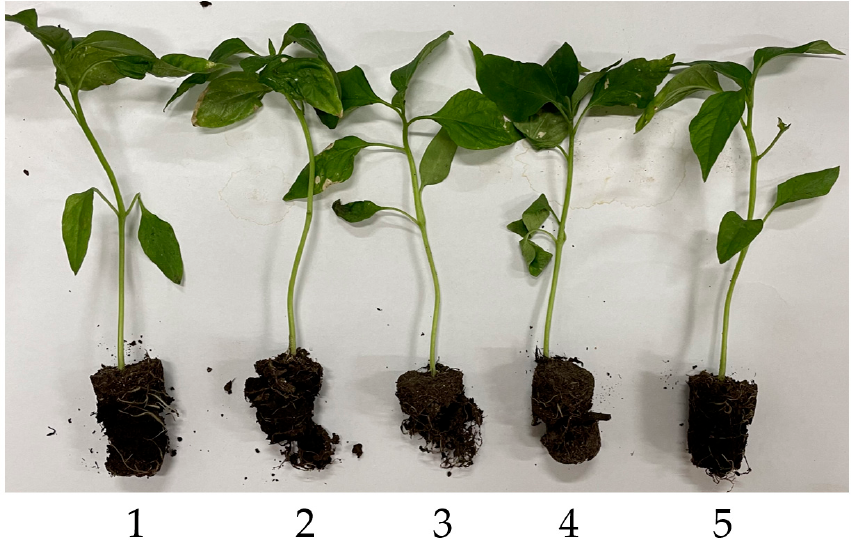
Figure 12. Pot body loss: (1), (4), (5) relatively complete pot body, (2), (3) relatively loose pot body.